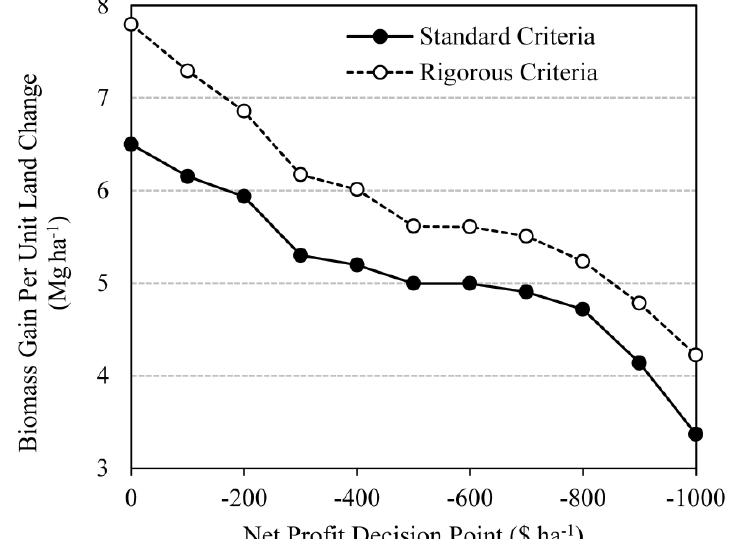
Figure 5. Increase in annual county level sustainable biomass production relative to the area converted as switchgrass is implemented into Hardin County, Iowa at a range of net profit decision points for the standard conservation criteria (soil erosion < T and SCI > 0) and rigorous conservation criteria (soil erosion < ½ T and SCI and SCI-OM >